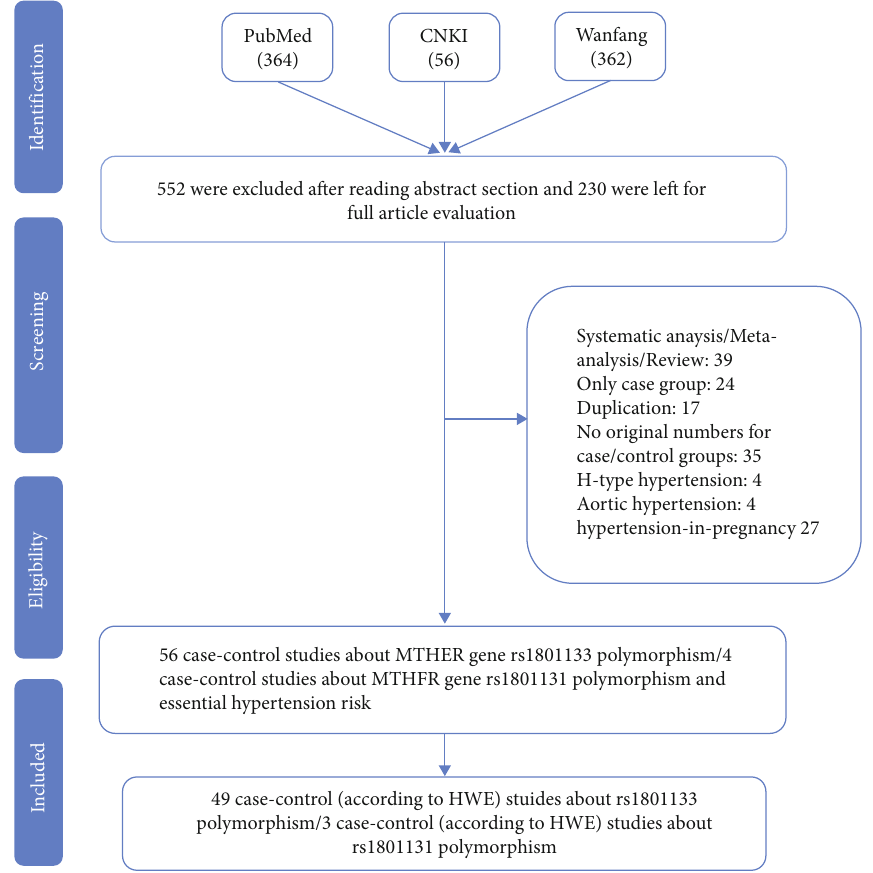
Figure 1: Flowchart illustrating the search strategy used to identify association studies for MTHFR gene rs1801133 polymorphisms and EH